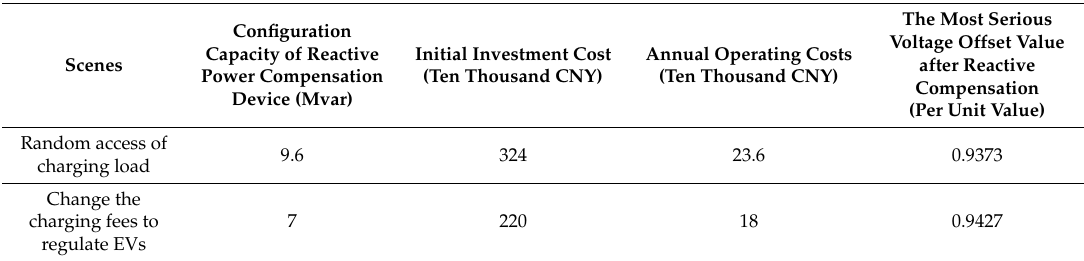
Table 3. Cost of reactive-load compensation equipment before and after charging fee